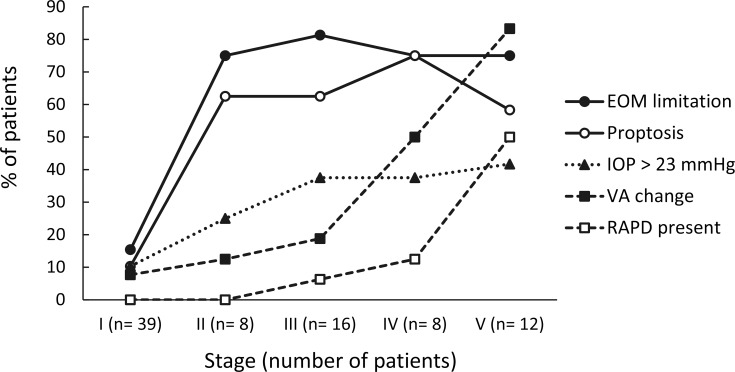
Percentages of acute ophthalmological findings in 83 patients by stage of orbital complications of sinusitis.The increasing incidences of acute ophthalmological findings by stage were categorized into three patterns. “EOM limitation” and “proptosis” substantially increased from stage II, and thereafter were sustained at high percentages during stages III–V. “IOP > 23 mmHg” increased steadily by stage. The incidences of “VA change” and “RAPD present” substantially increased at stages IV and V respectively. Abbreviations: EOM, extraocular movement; IOP, intraocular pressure; RAPD, relative afferent pupillary defect; VA, visual acuity.